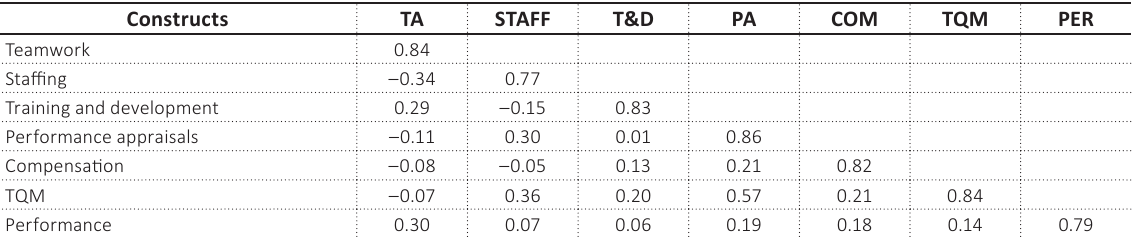
Table 4. Fornell and Larcker (1981) criterion